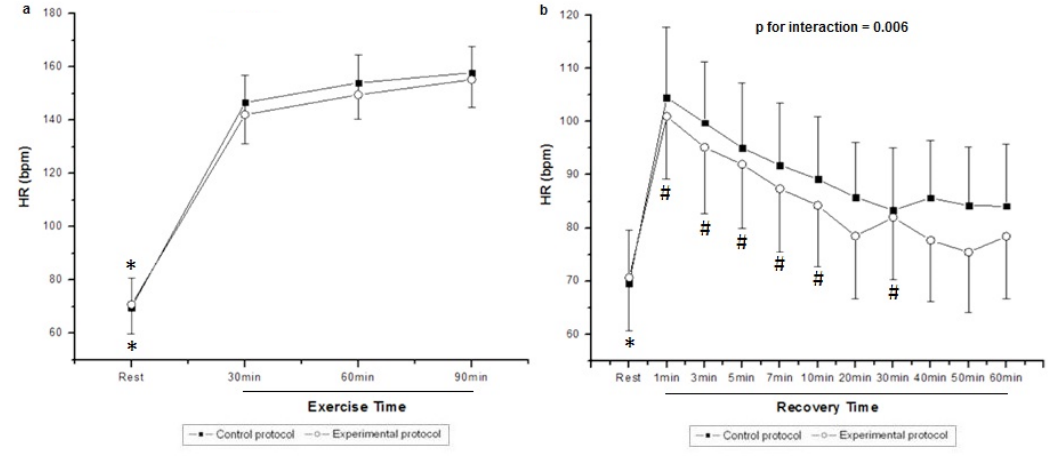
Figure 1. Values are mean ± standard deviation. Heart rate (HR) during (a) exercise and (b) recovery, and the comparison in control and experimental protocols; *Different from all the times of exercise and recovery (p < 0.05); #Different from M1 (p < 0.05); HR, heart rate; bpm, beats per minute.